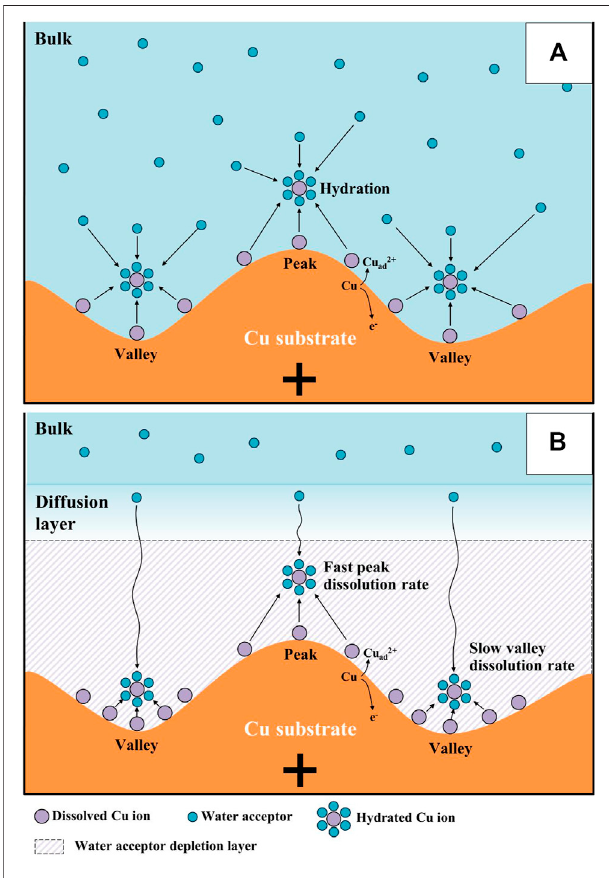
FIGURE 8 | Mechanism scheme of Cu electrochemical polishing: (A) initial state, and (B) steady state.